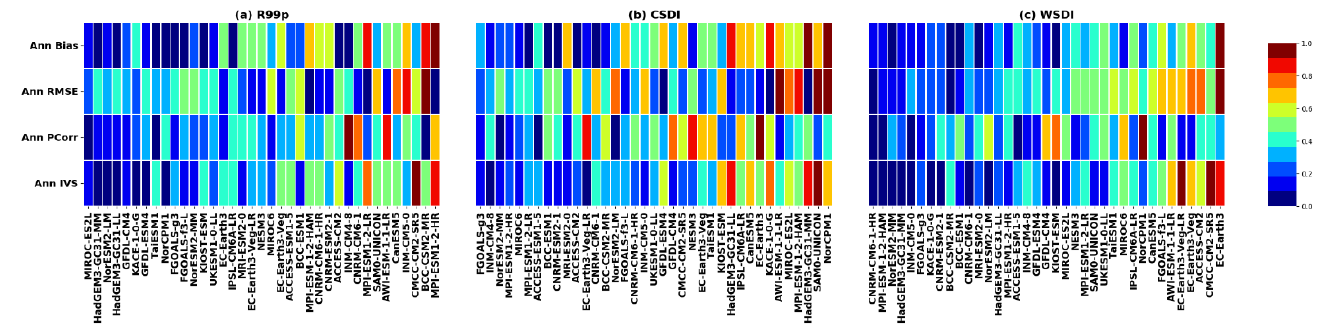
Figure 14. Normalised and continentally averaged annual means of individual metrics (bias, root mean square error (RMSE), pattern correlation (PCorr) and interannual variability score (IVS)) for the extreme indices ( a ) total annual precipitation from very heavy rain days (R99p), ( b ) annual count of nights with at least 4 consecutive nights when daily minimum temperature < 10th percentile (CSDI) and ( c ) annual count of days with at least 4 consecutive days when daily maximum temperature > 90th percentile (WSDI). Here, the smaller values of normalised metrics correspond to the better performance of GCMs. Moreover, for each extreme index, GCMs are arranged from best to worst performance as we move from left and right. Data spans 1951–2014.